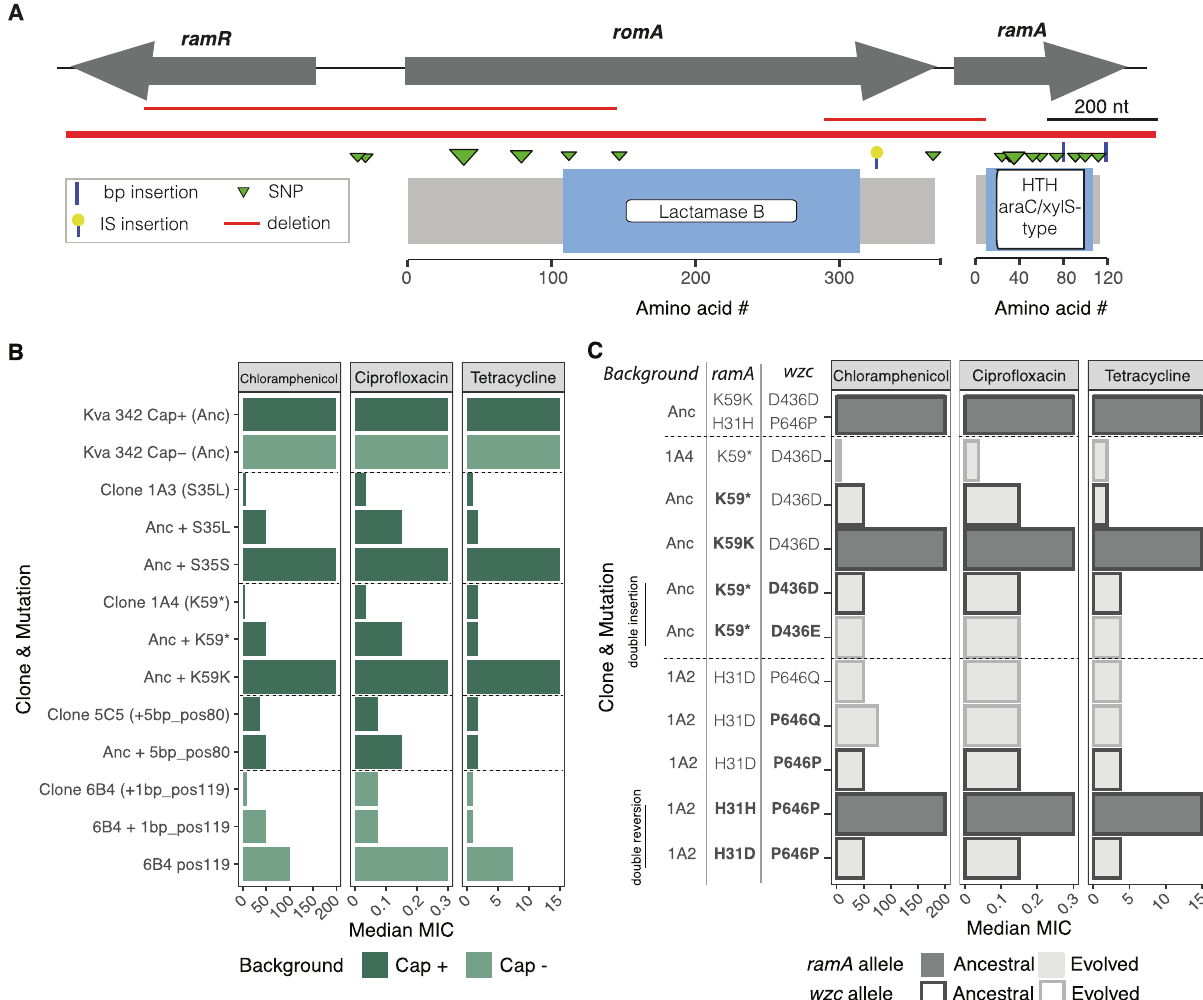
position of the mutation in the gene. C MIC of capsulated double mutants. The latterweregeneratedeitherbyinsertingintheancestralbackground fi rstthe ramA and then the wzc allele from the evolved clone 1A4, or by reverting the wzc allele fi rst and then the ramA allele to the ancestral one in the evolved clone 1A2. The allelesthatweremodi fi edineachstrainarehighlightedinbold.MICisexpressedas µ g/mL. The median of three independent experiments is represented. Source data are provided as a Source Data fi